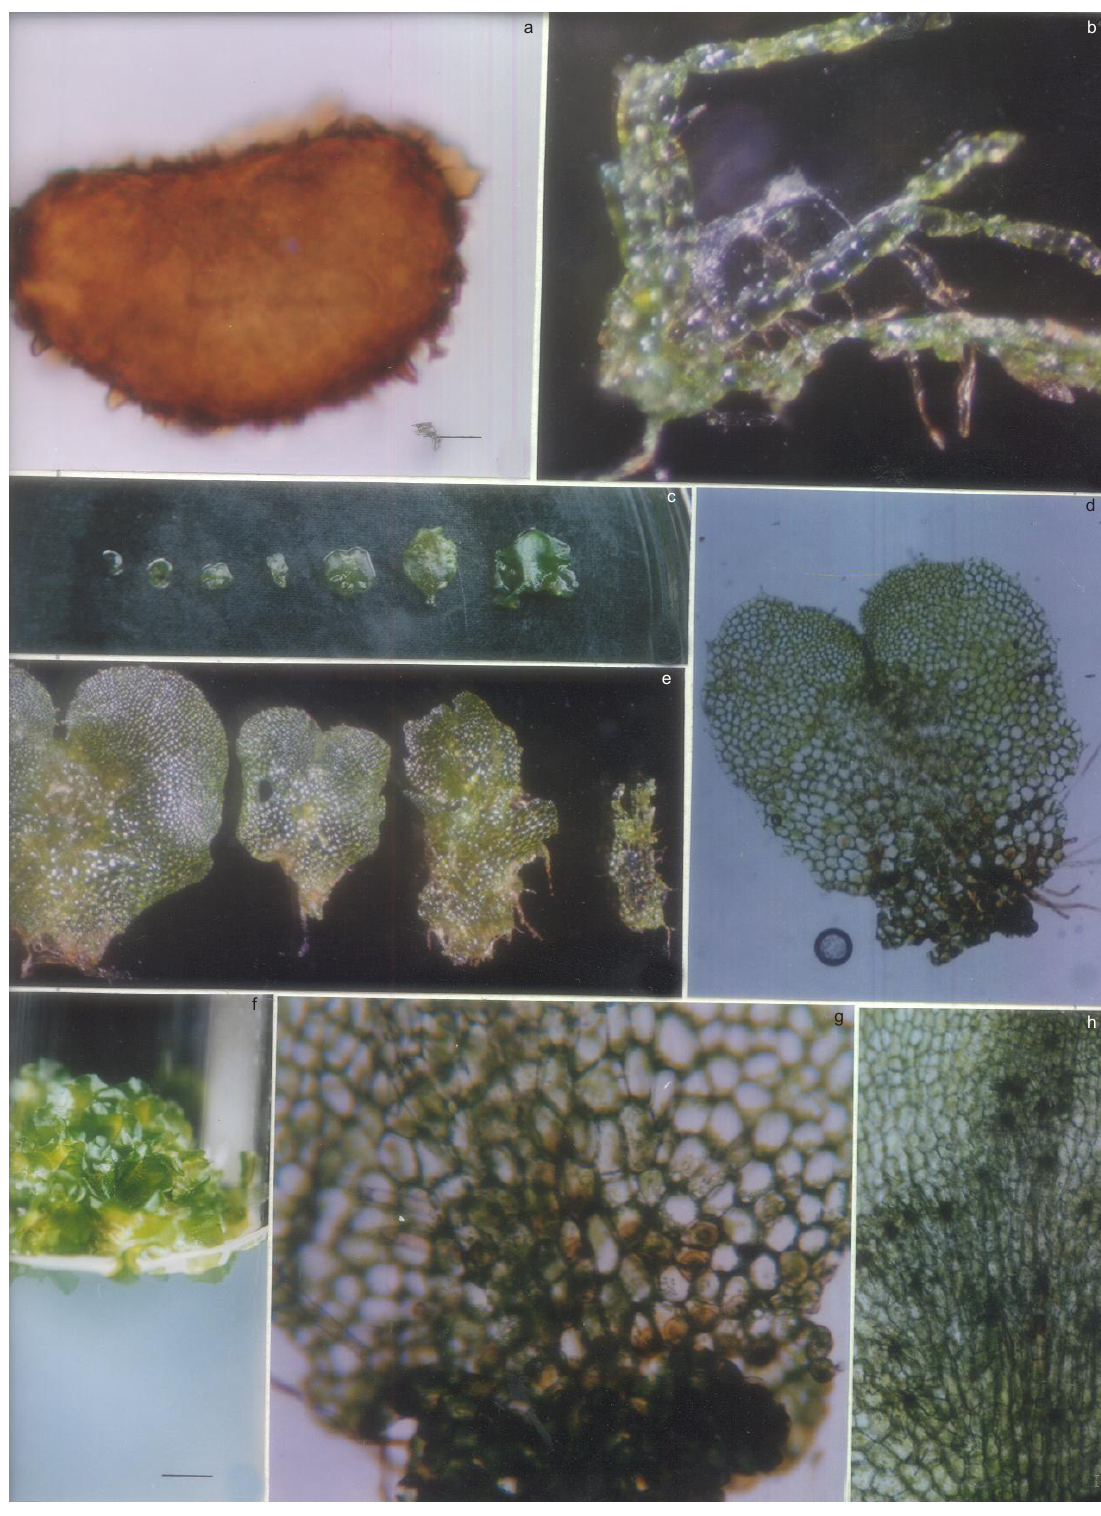
Image 1. In vitro spore culture: Different developmental stages of Pronephrium triphyllum a - Spore (bar 1cm = 4µm); b - Filamentous stage (bar 1cm = 250µm); c - Different stages of prothalli - Camera view (bar 1cm = 250mm); d - Cordate prothallus (bar 1cm = 250mm); e - Different stages of prothalli - microscopic view (bar 1cm = 400µm); f - Matured prothalli (bar 1cm = 4mm); g - Cordate prothallus with male sex organs (bar 1cm = 400µm); h - Cordate prothallus with female sex organs (bar 1cm =